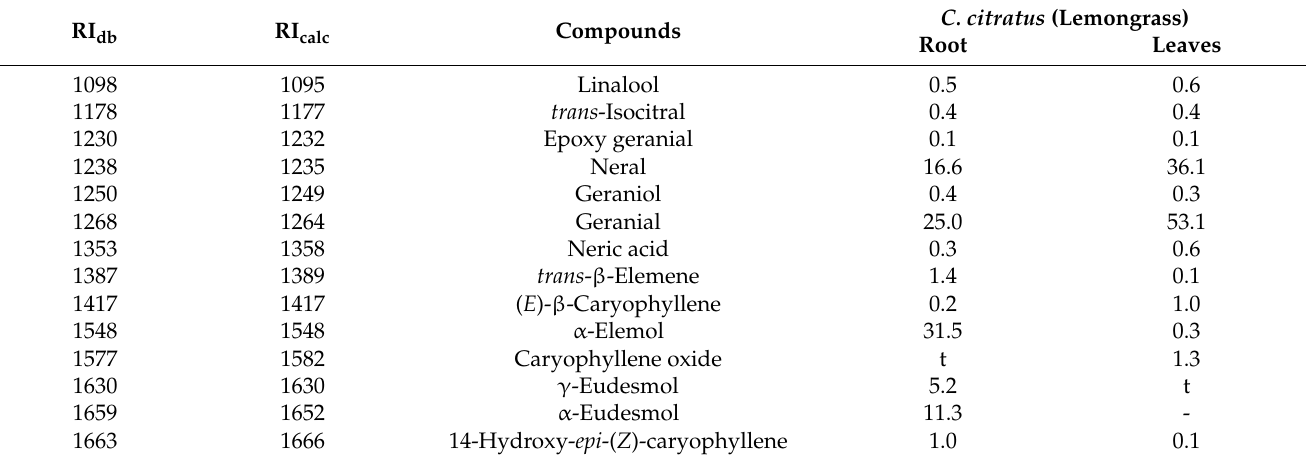
Table 3. Selected constituents of C. citratus essential oils extracted from root and leaves.